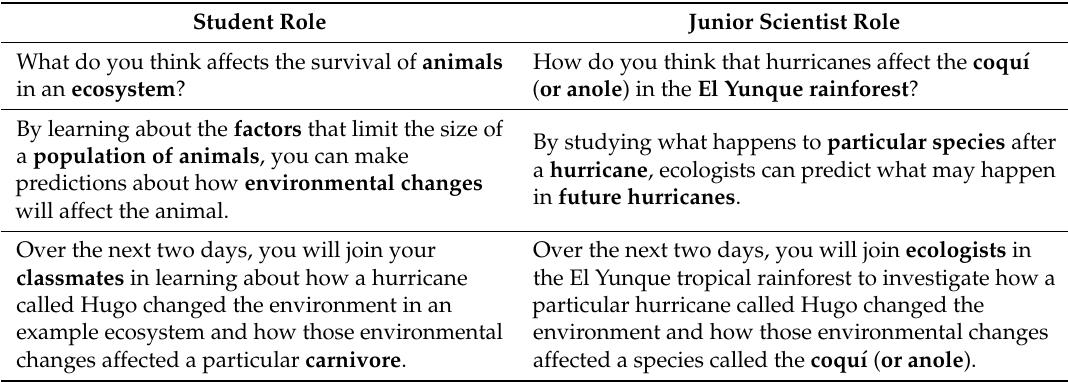
Table 1. Introductory instructions for each of the experimental